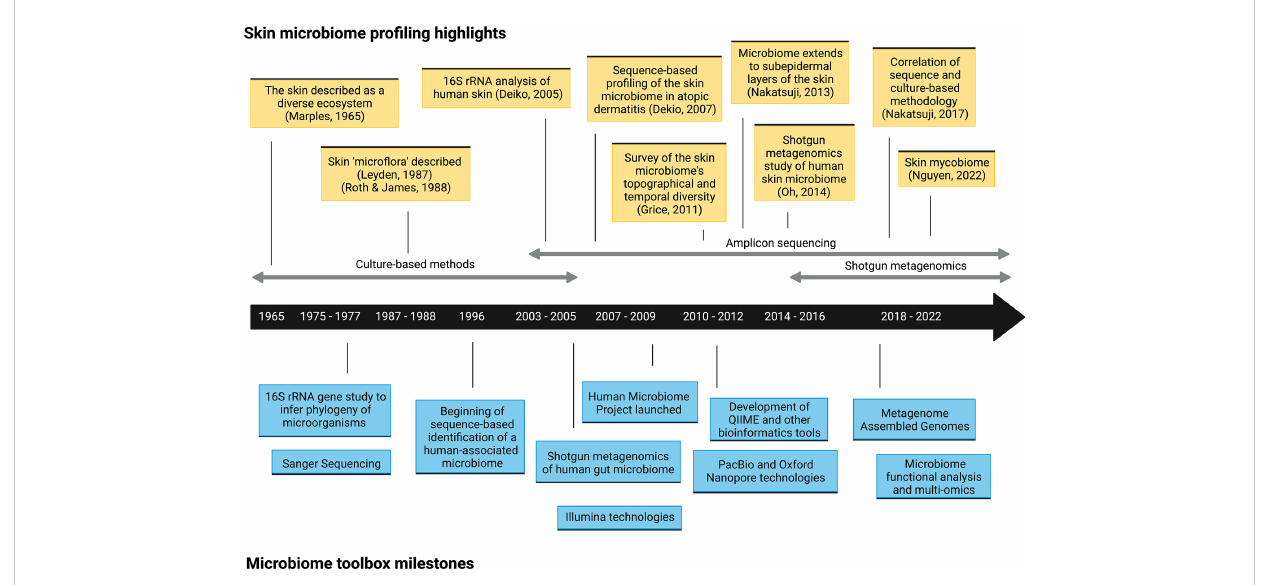
FIGURE 1 Timeline of selected microbiome toolbox milestones and skin microbiome pro fi ling